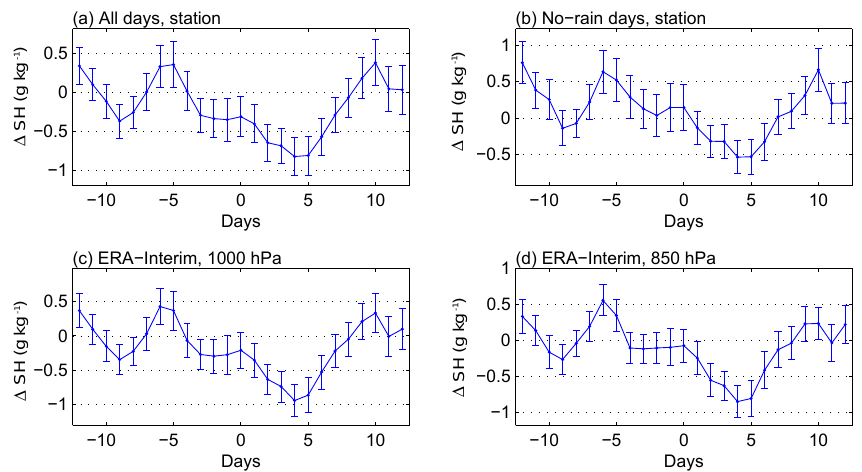
Figure 7. Means of station-specific humidity anomalies ( (cid:49) SH) during the holiday from 1979 to 2012 as estimated from all available days (a) and no-rain days (b) . The corresponding ERA-Interim (cid:49) SH at 1000hPa (c) and 850hPa (d) are also plotted.